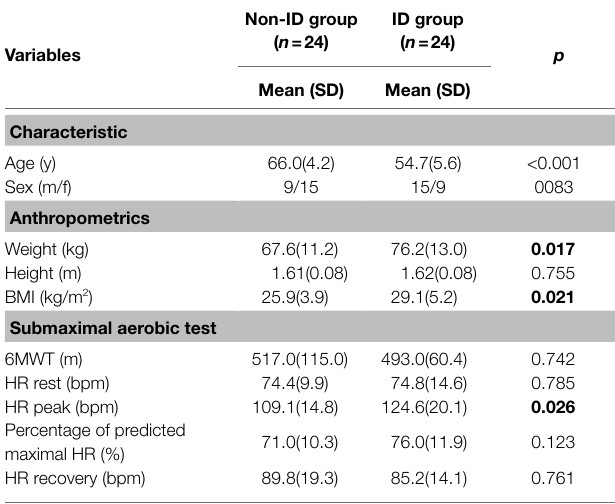
TABLE 1 | Participants’ characteristics, anthropometry, and submaximal aerobic capacity.